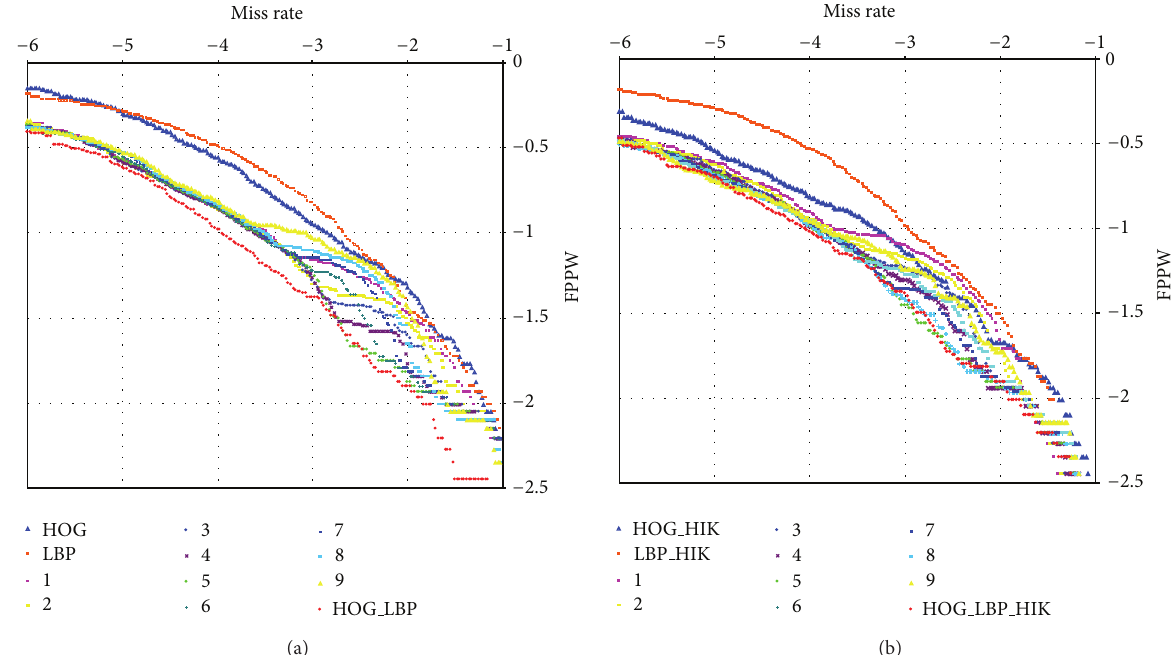
Figure 5: Comparison of accuracies achieved by combining HOG and LBP features through FF1 and FF2 methods on the INRIA dataset. The classifiers are linear SVM and HIKSVM in (a) and (b),